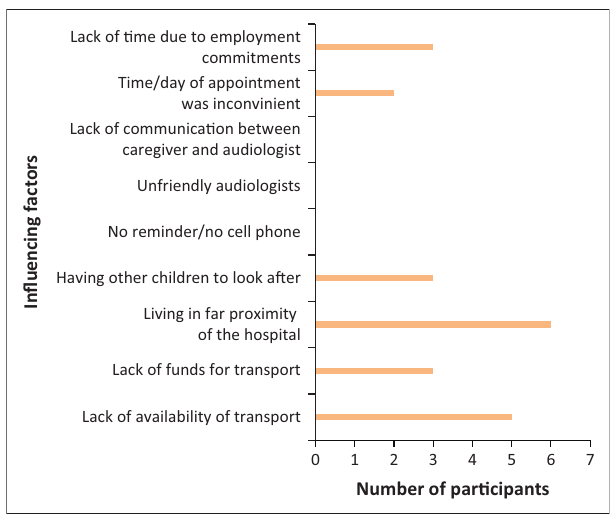
FIGURE 2: Perceived challenges influencing caregiver’s